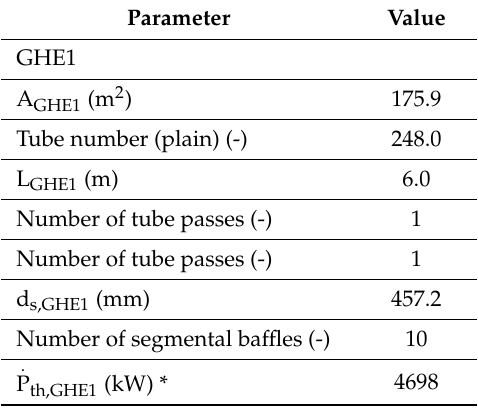
Table A3. Geothermal heat exchanger output